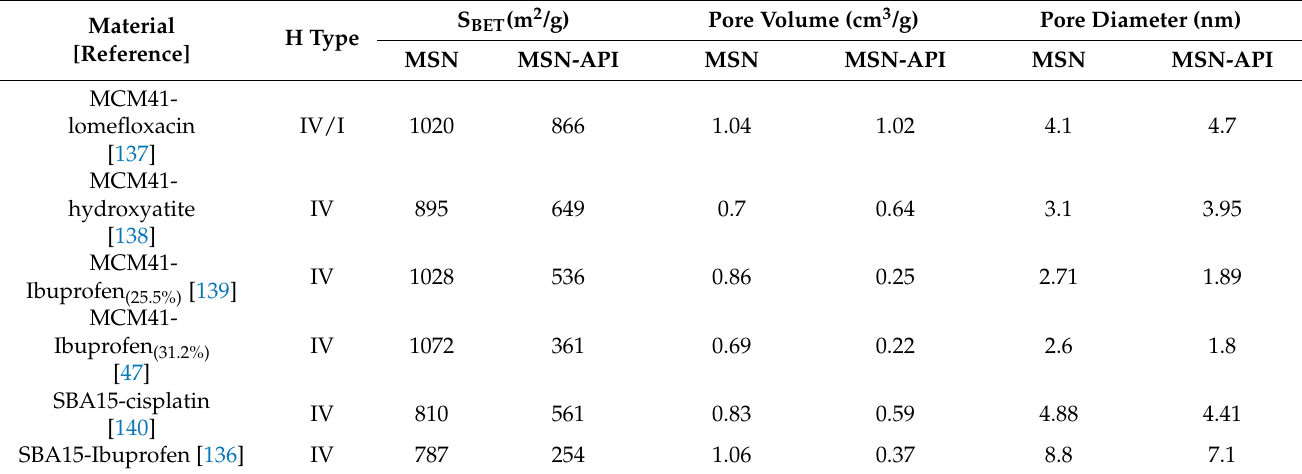
Table 2. Structure parameters of the selected API loaded in